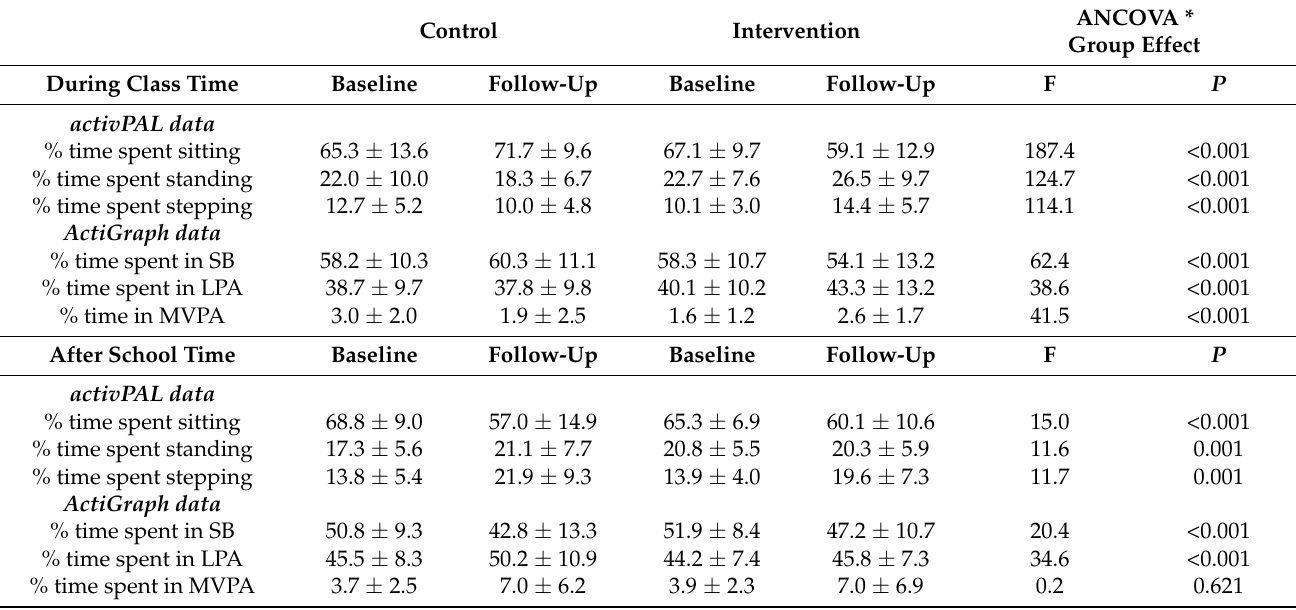
Table 3. Percentage of wear time spent in device-measured behaviour (mean ± SD) and the preliminary effect of the treatment (intervention).